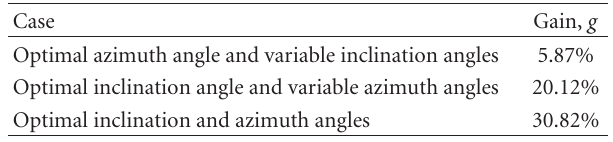
Table 1: Summary of the improvements for tracking PV systems over fixed systems.